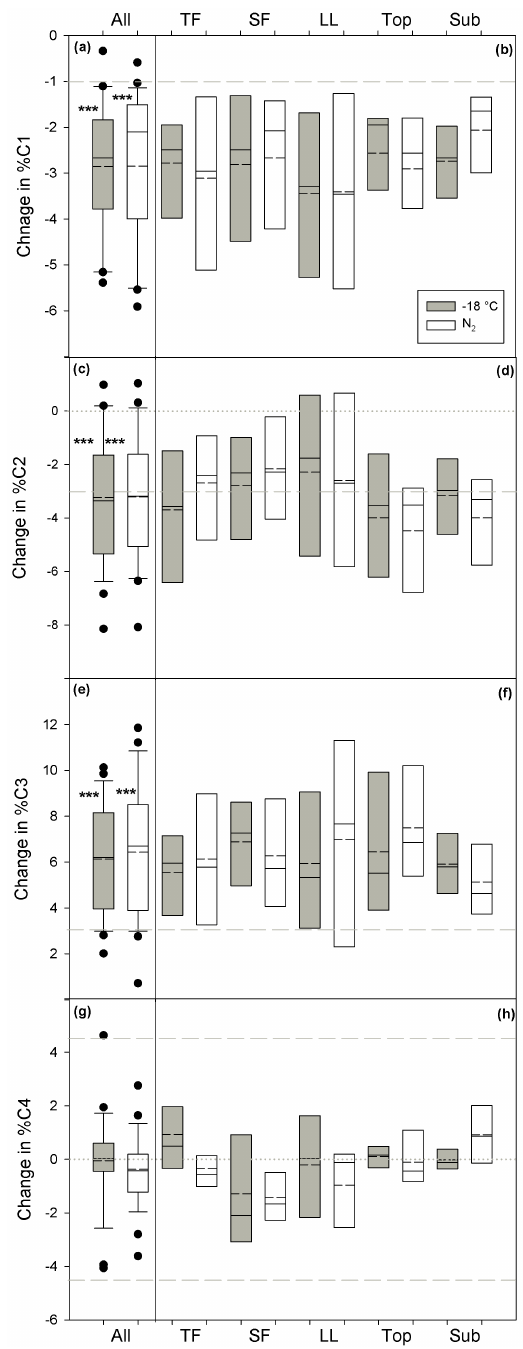
Figure 3. Changes of relative distribution of PARAFAC compo- nents after freezing ( − 18 ◦ C) and fast-freezing with liquid nitrogen; (a, c, e, g) all samples ( n = 27); (b, d, f, h) ordered by sample type (throughfall (TF) n = 6, stemflow (SF) n = 5, litter leachate (LL) n = 5, top soil solution (Top) n = 6, sub-soil solution (Sub) n = 5); gray dashed line: analytical reproducibility; ∗∗∗ significant changes (linear mixed models (lme), p< 0.05) ; boxplots: solid line: median, dashed line: